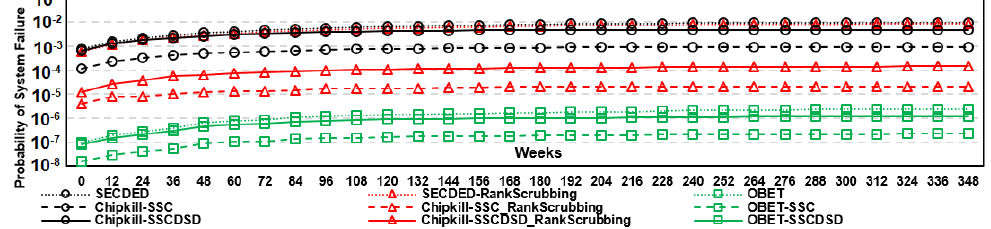
Figure 10. The probability of system failure over a period of 7 years based on uniform random errors: a comparison between commercialized cases and OBET